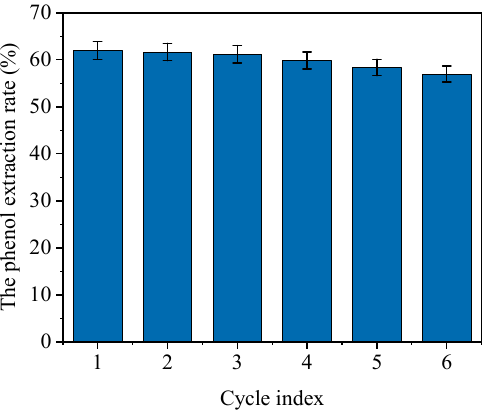
Figure 12. Effect of cycle number on phenol extraction rate.